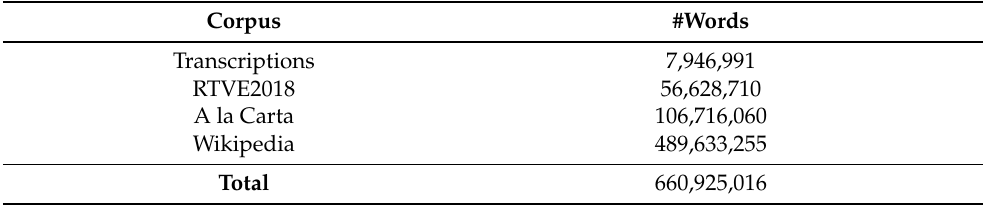
Table 2. Description of the text